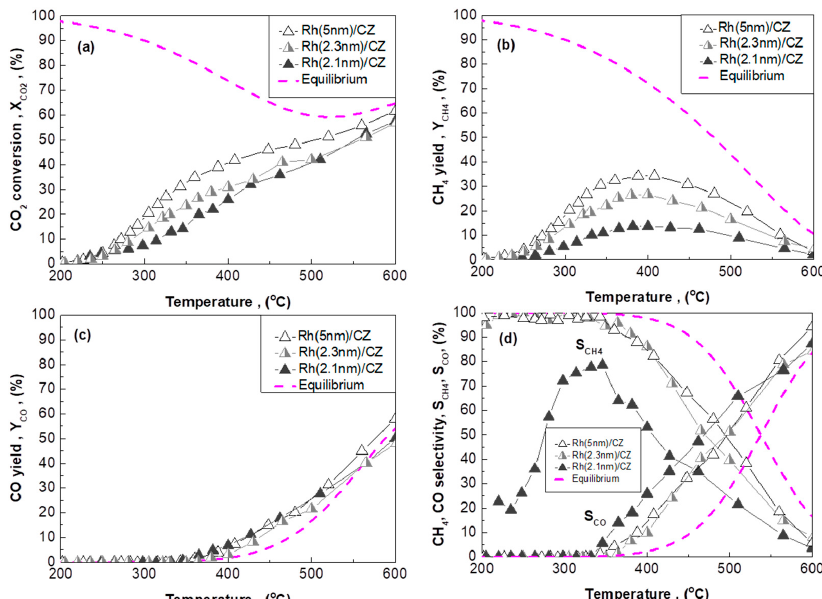
Figure 7. CO 2 hydrogenation performance ( X CO2 ( a ), Y CH4 ( b ), Y CO ( c ), S CH4 and S CO ( d )) of Rh(5nm)/CZ, Rh(2.3nm)/CZ, and Rh(2.1nm)/CZ catalysts under integral reaction conditions. Experimental conditions: feed composition of 5% CO 2 /20% H 2 /75% Ar at 1 bar; mass of catalyst m cat = 50 mg; fixed mean contact time of CO 2 at τ (CO 2 )~1.3 s, corresponding to wGHSV values of 24,000, 50,400, and 56,400 N mL/g ∙ h for the Rh(5nm), Rh(2.3nm), and Rh(2.1nm)/CZ catalysts, respectively.